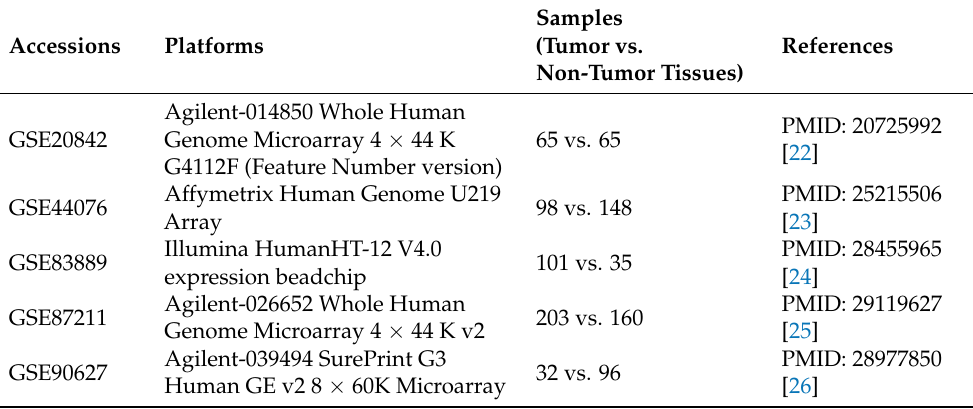
Table 1. Information on the included GEO